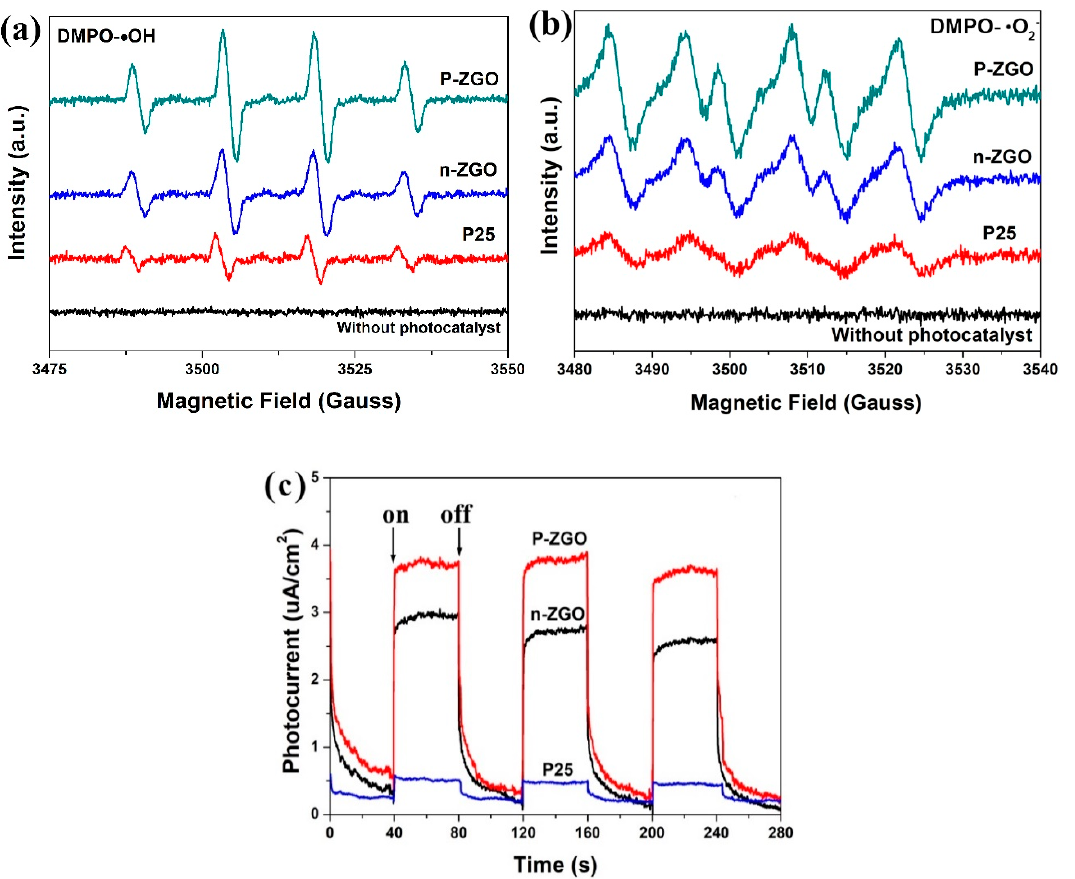
Figure 8. The DMPO spin-trapping ESR spectra in an aqueous dispersion for ( a ) DMPO–•OH and ( b